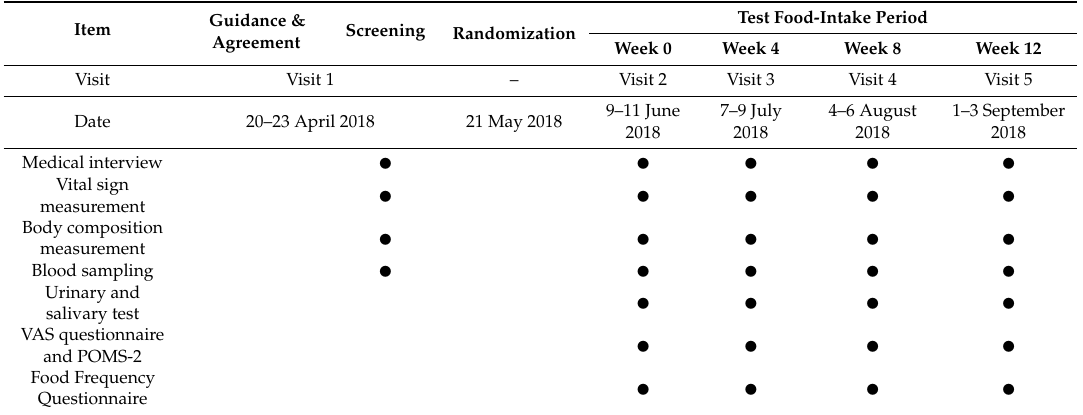
Table 1. Clinical trial